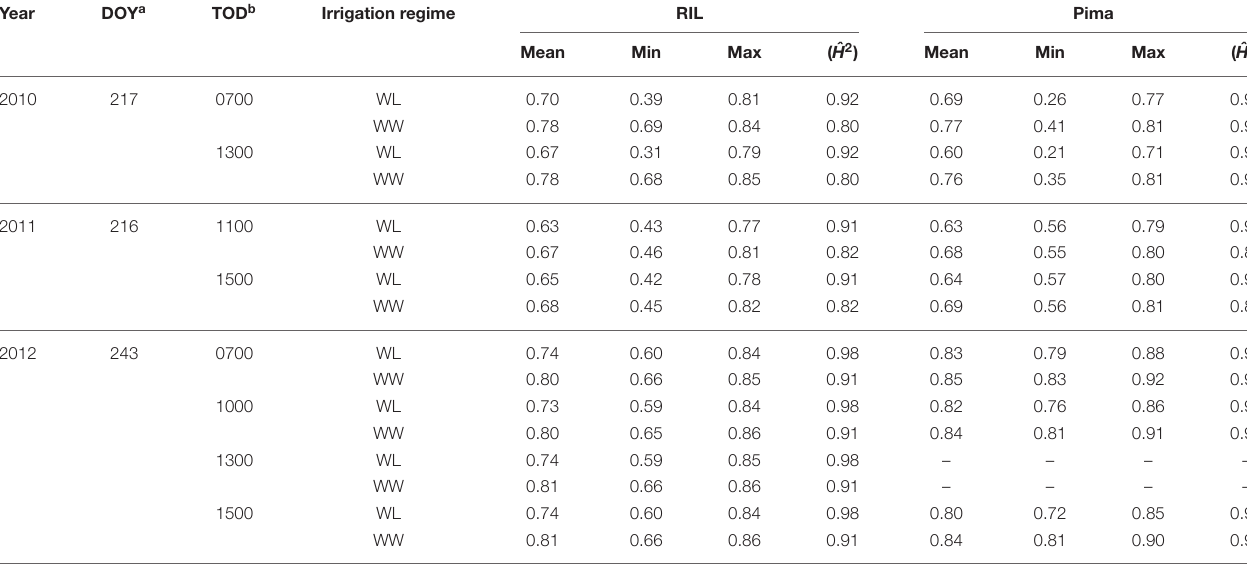
TABLE 3 | Mean, minimum, maximum of best linear unbiased estimators (BLUEs) of normalized difference vegetation index (NDVI) for the upland recombinant inbred line (RIL) and Pima populations tested under two irrigation regimes, water-limited (WL) and well-watered (WW)